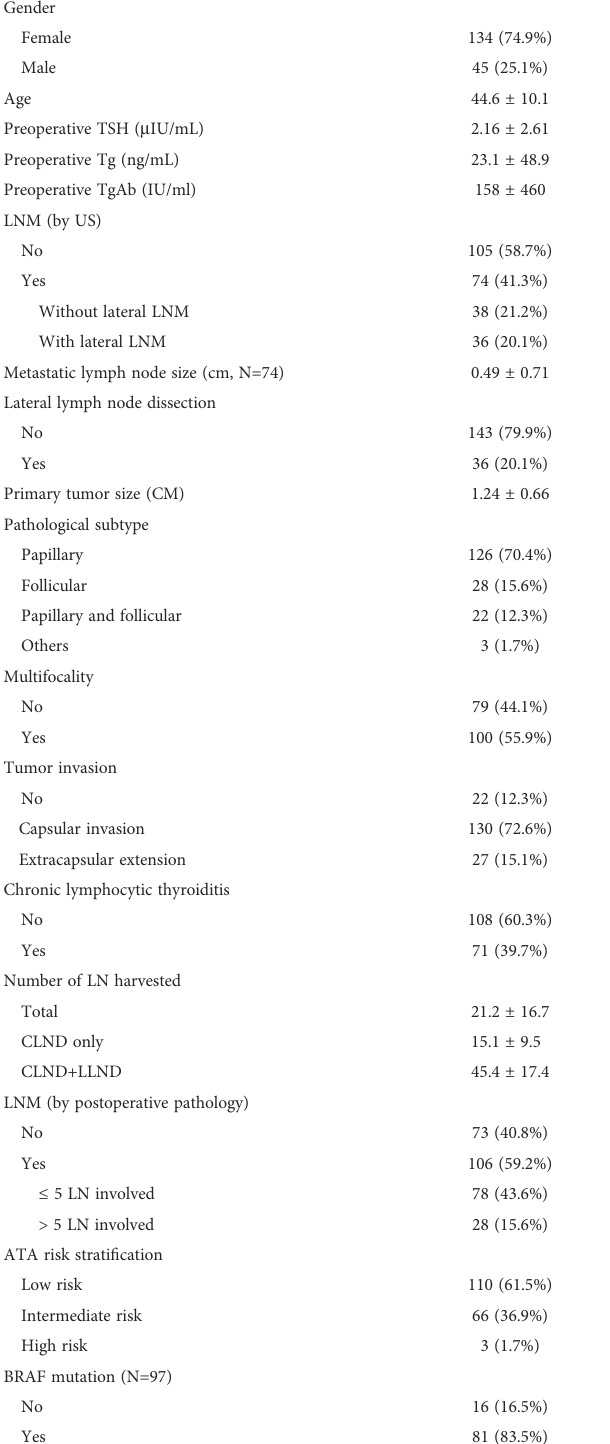
TABLE 1 Demographic and clinicopathologic characteristics of included patients.